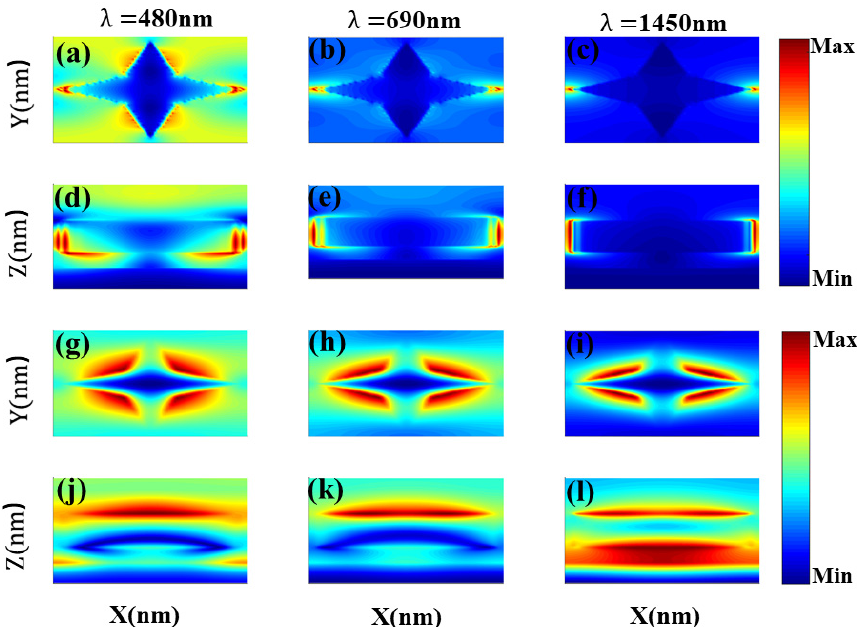
Figure 3. ( a – c ) distributions of the electric field |E| (color bar in the X-Y plane) and ( d – f ) electric field |E| (color bar in the X-Z plane), ( g – i ) distributions of the electric magnetic |H| (color bar in the X-Y plane) and ( j – l ) magnetic field |H| (color bar in the X-Z plane); the corresponding wavelengths of each column of images are 480 nm, 690 nm and 1450 nm, respec-